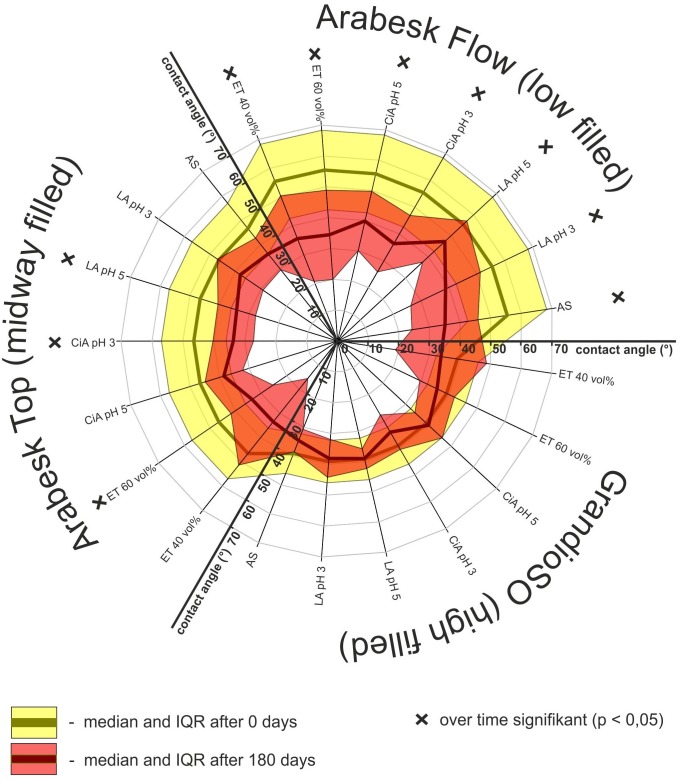
CA (sessile drop method; test liquid: artificial saliva) after 0 (yellow) and 180 (red) days.